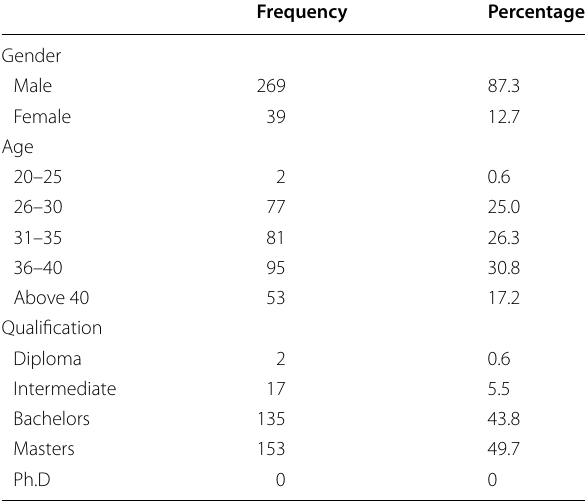
Table 1 Frequency analysis of